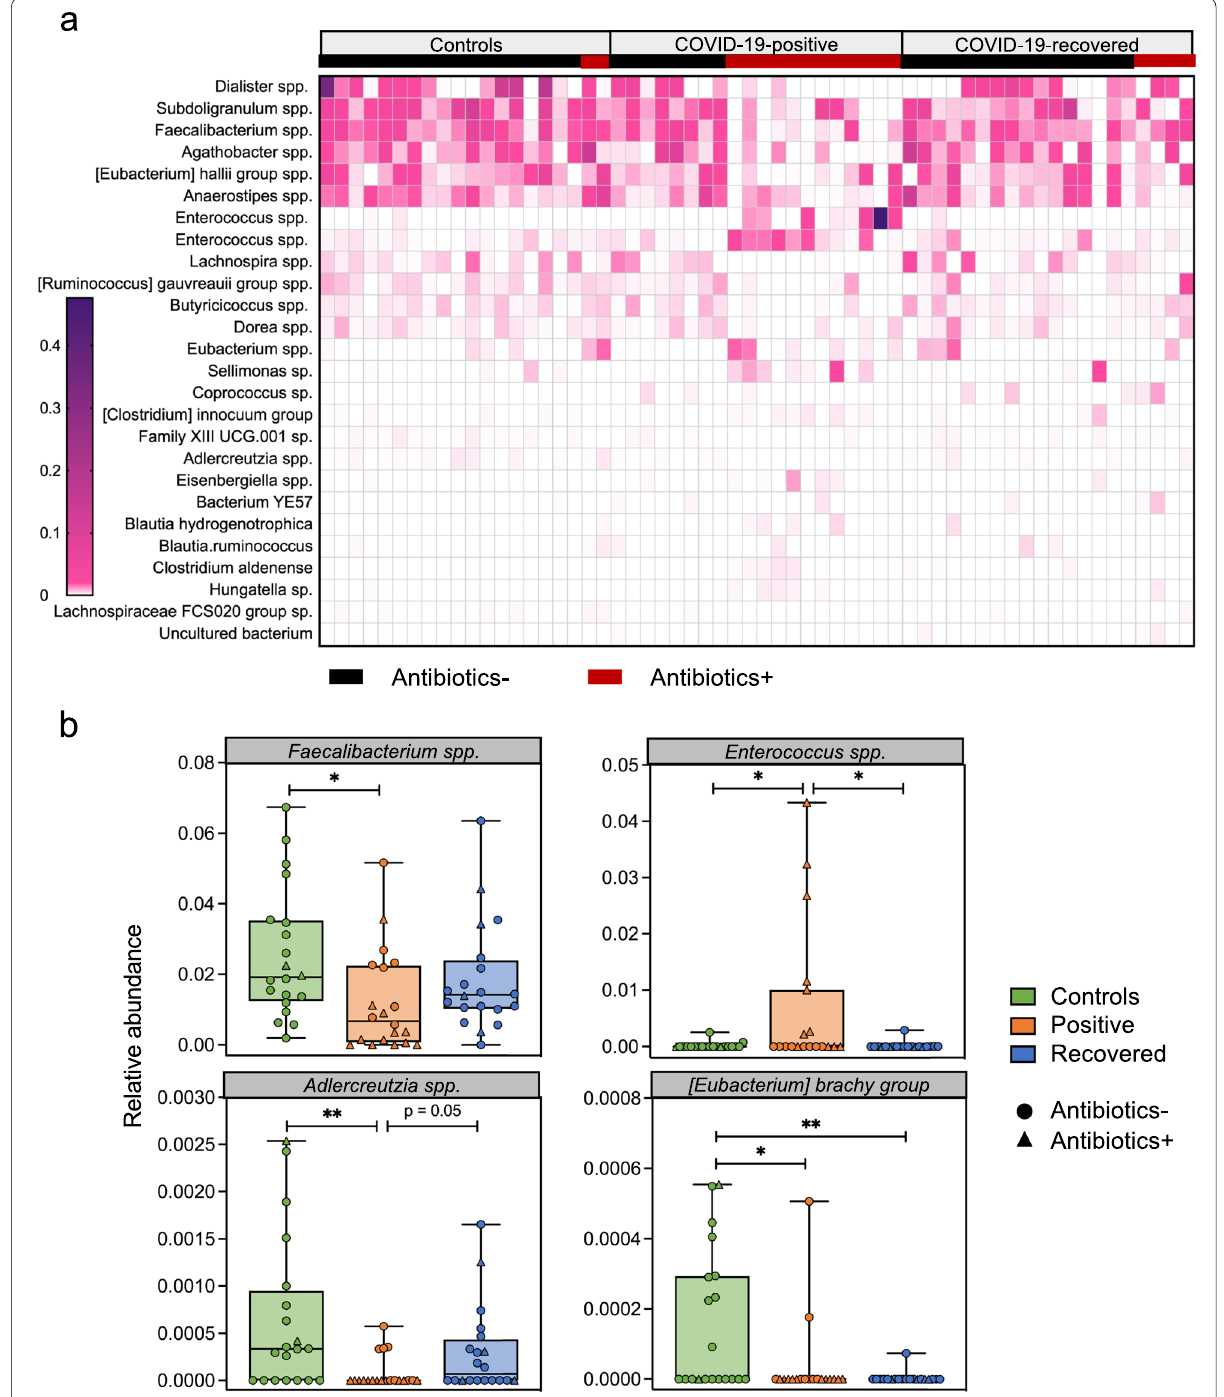
Fig. 4 Bacterial species that significantly differ in abundance in groups differing in COVID-19 infection status or antibiotic use status. a Heatmap of bacterial species found to significantly differ in abundance between groups differing in COVID-19 infection status or antibiotic use status is shown for the Controls, COVID-19-positive, and COVID-19-recovered patients. Subjects with (red) or without (black) recent antibiotic exposure is indicated in the top line. Table 1 indicates the number of subjects in each group. Differentially abundant species were identified by MaAsLin2 and ordered according to mean relative abundance. b Four bacterial species were determined by MaAsLin2 to be significantly differential between the Controls, COVID-19-positive, and COVID-19-recovered patients. Additional statistical comparisons were performed concerning the relative abundance of these species: * p < 0.05 and ** p < 0.01 by Welch’s